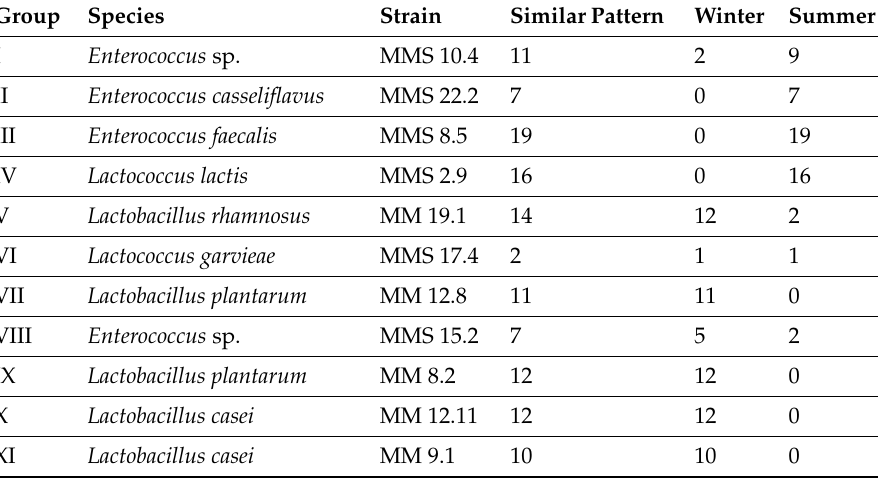
Figure 3. Rep-PCR patterns showing the representative fingerprints of the lactic acid bacteria isolates recovered from di ff erent milk samples from Maltese islands. The codes on the right correspond to the strain chosen from either the winter of the summer batch. MM-Maltese milk winter and MMS-Maltese milk summer. Table 2. Identified strains by sequencing and the number of isolates that similar patterns were obtained by rep-PCR from the total amount of isolates recovered from the winter and summer raw cow milk samples of Maltese